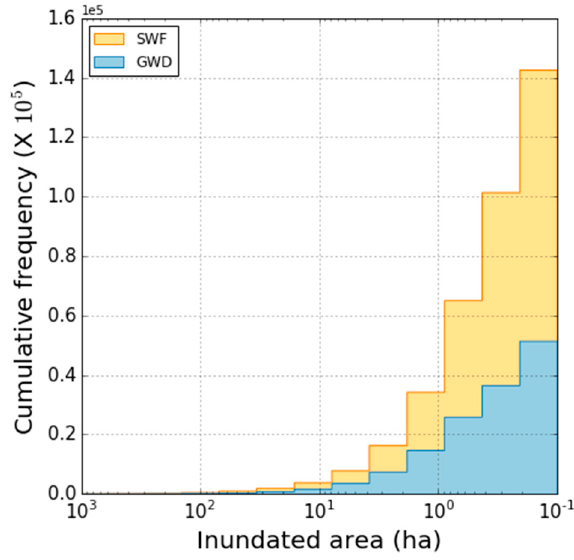
Figure 6. Cumulative distribution of the inundated area of individual wetlands detected over a single Landsat path/row (37/25) in the Prairie Pothole Region. Area estimates based on the Global Surface Water Dataset (GWD; blue) [14] are derived from the maximum inundated extent over the 1984 to 2015 period. SWF-based estimates (orange) are derived from the median SWF estimated from all Landsat TM data acquired in 2005 between April and August, inclusively.